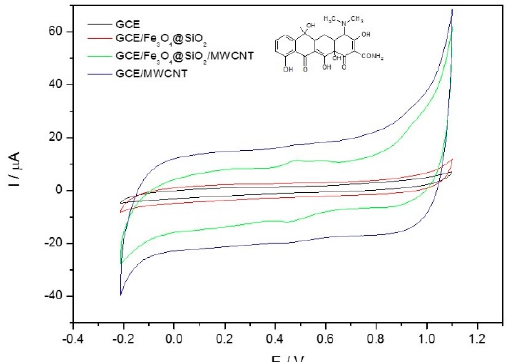
Figure 6. Cyclic voltammograms obtained using different electrodes: GCE; GCE/Fe 3 O 4 @SiO 2 , GCE/MWCNT, and GCE/MWCNT/Fe 3 O 4 @SiO 2. Measurements performed in the presence of 22.0 µmol L − 1 of tetracycline in 1 × 10 − 3 mol L − 1 HCl at pH 3.0. Scan rate: 25mV s − 1 .